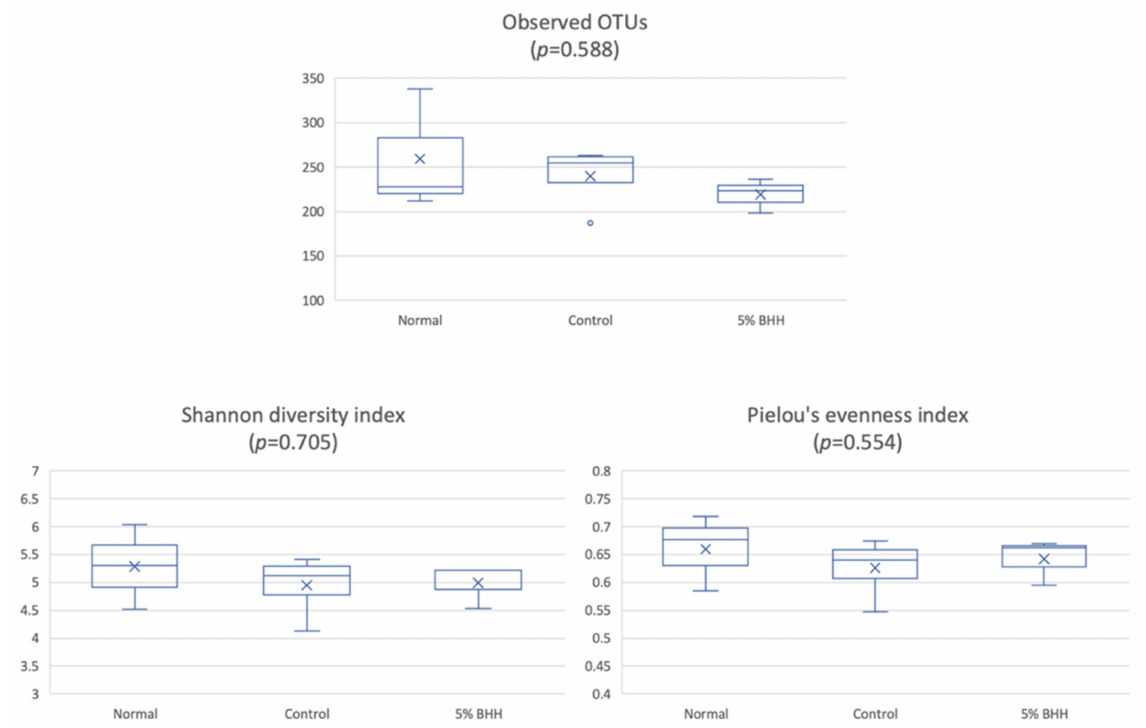
Figure 3. Alpha-diversity among each treatment group, Normal, Control, and 5% BHH by the observed OTUs, Shannon diversity index, and Pielou’s evenness index. The p -value by Kruskal–Wallis test in all groups. Normal ( n = 3), Control ( n = 4) and 5% BHH ( n = 3) are